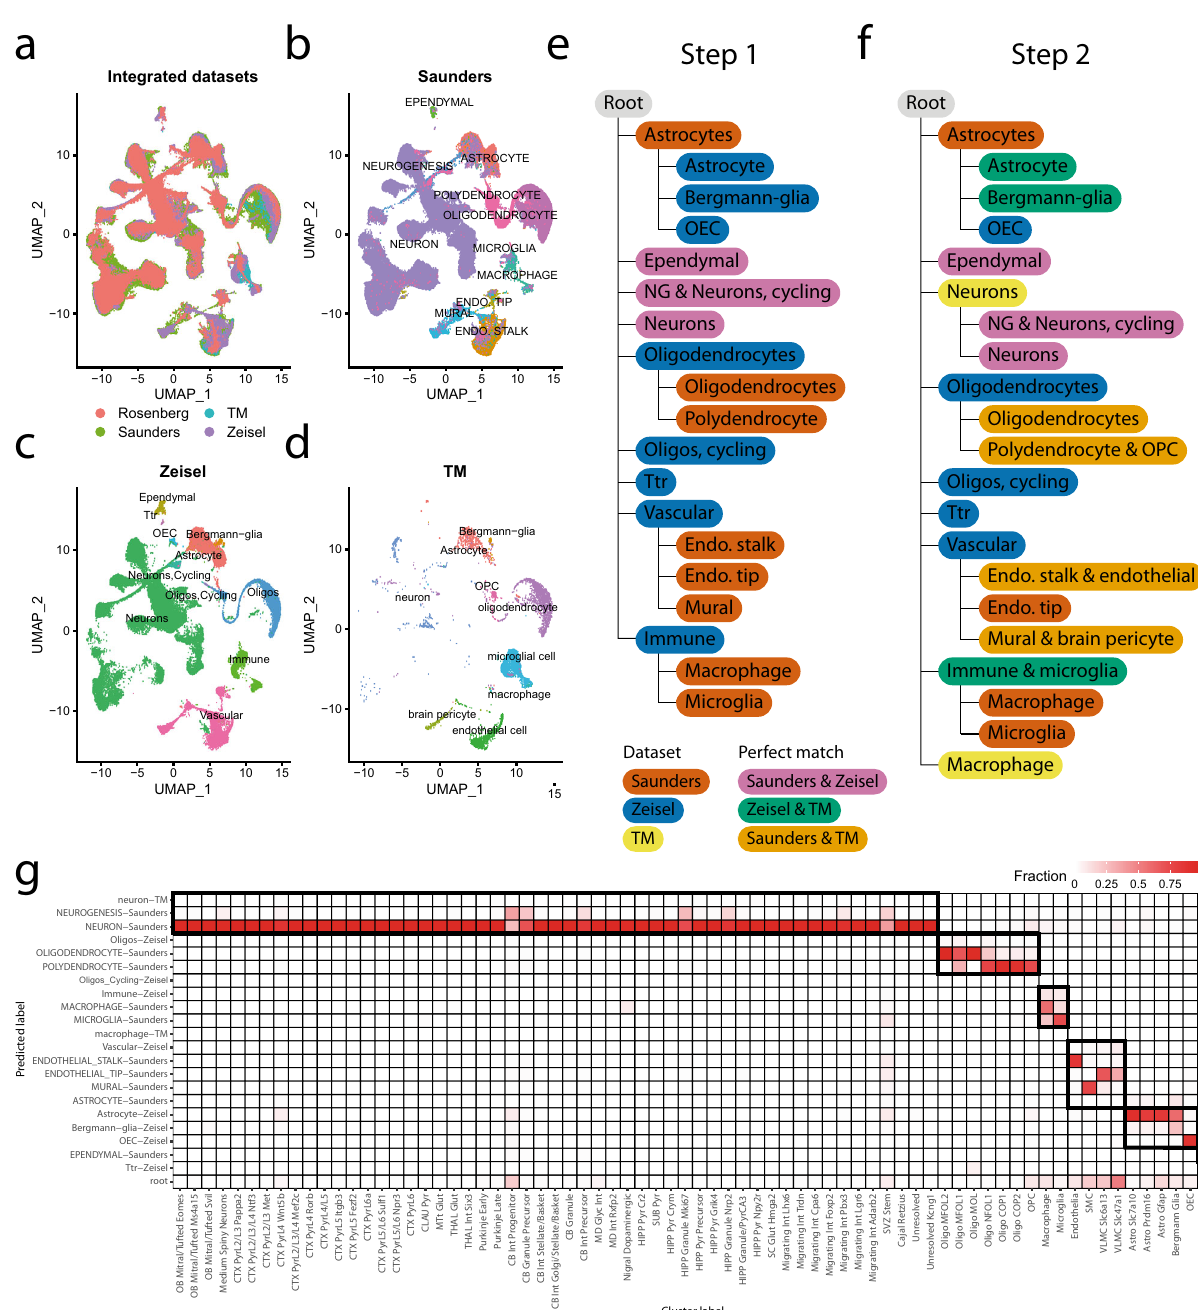
Fig. 7 Brain inter-dataset evaluation. a – d UMAP embeddings of the datasets after alignment using Seurat v3. e Learned hierarchy when starting with the Saunders dataset and adding Zeisel with linear SVM. f Updated tree when the Tabula Muris dataset is added. g Confusion matrix when using the learned classi fi cation tree to predict the labels of Rosenberg. The dark boundaries indicate the hierarchy of the classi fi cation